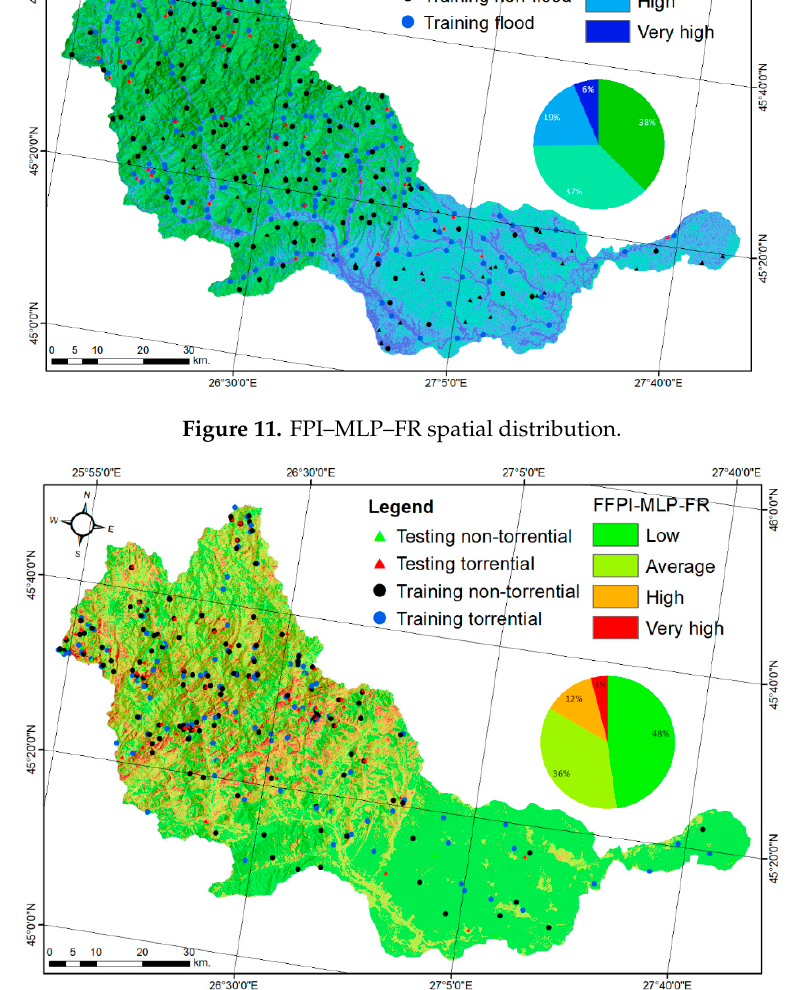
Figure 12. FFPI–MLP–FR spatial distribution.